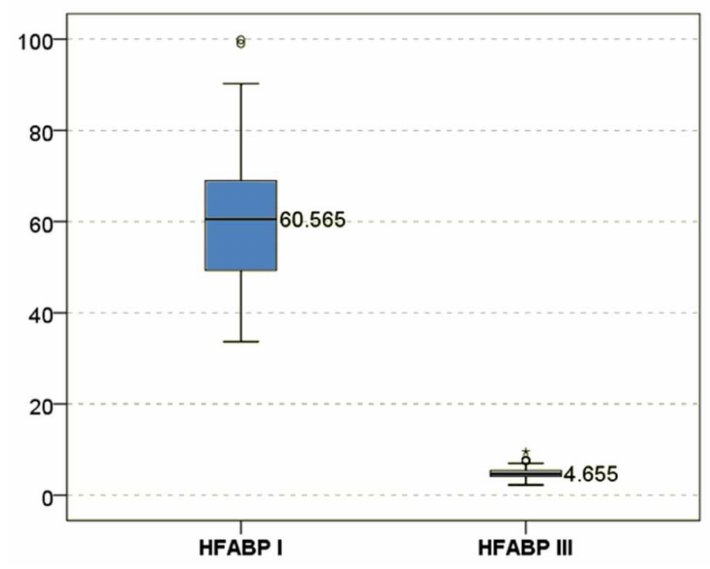
Figure 1. H-FABP differences between the two studied phases ( N =